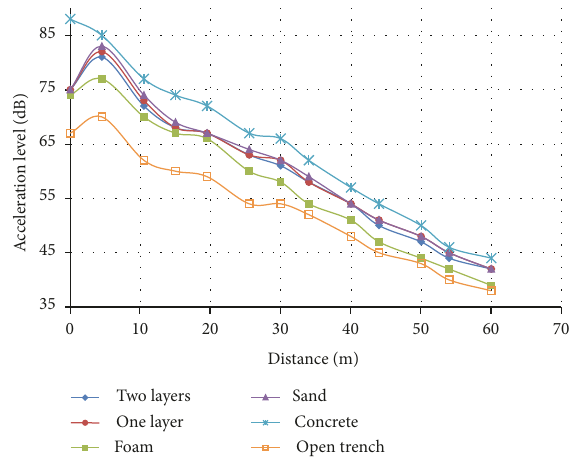
Figure 7: The relationship between the acceleration level and distance under case 2 .